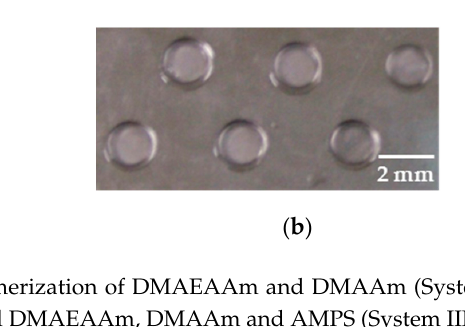
Table 1. Composition of hydrogels prepared for Systems I, II and III. D , N -[2-(dimethylaminoethyl)acrylamide]; M , N , N -dimethylacrylamide; B , N,N -methylenebisacrylamide; A , acrylic acid, S , 2-acrylamido-2-methyl-1-propanesulphonic acid [(Irgacure 2959, 0.1 mmol; distilled water, 3.5 mL). The superscript a stands for the concentration of crosslinker in % (mmol/mmol) with respect to the